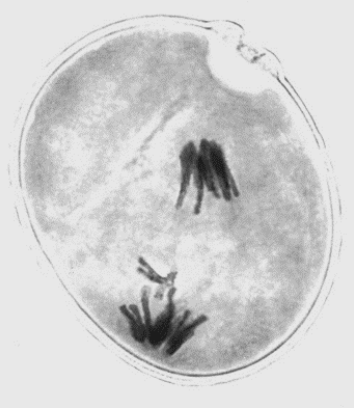
Figure 1. Nondisjunction of a rye B at first pollen grain mitosis (photo by author).